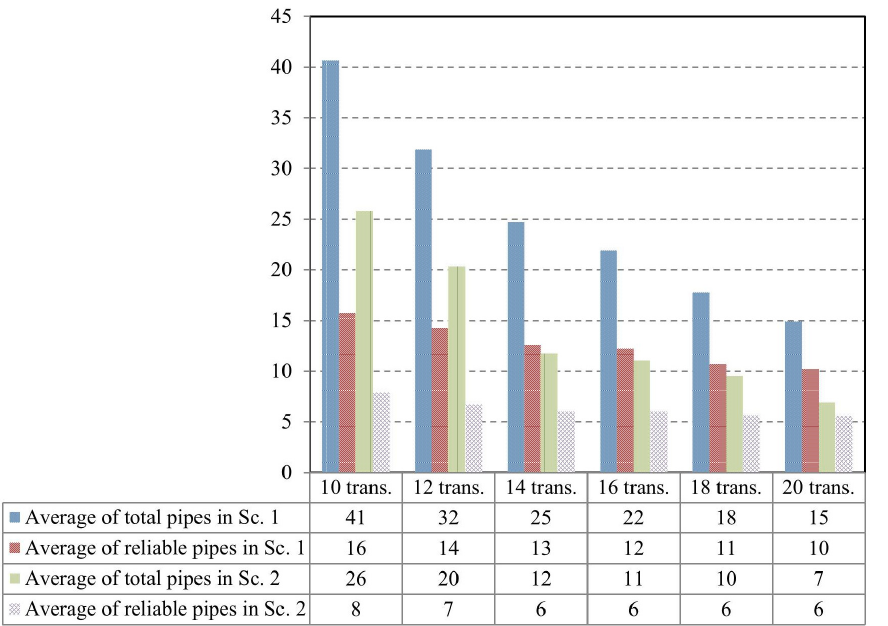
Figure 9. Average of total and reliable leaky pipes for both scenarios and the two WDN.